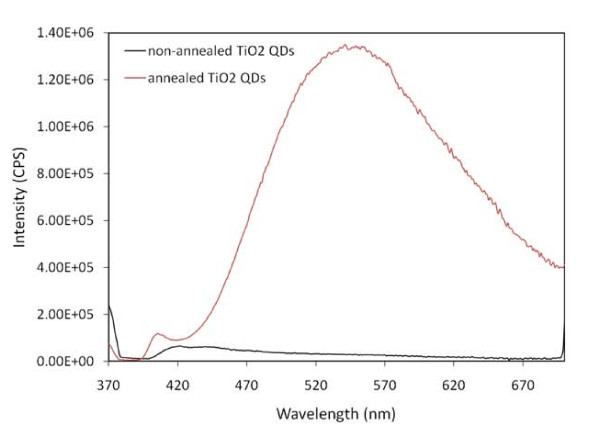
Fluorescence spectra of annealed and non-annealed TiO2 QDs.